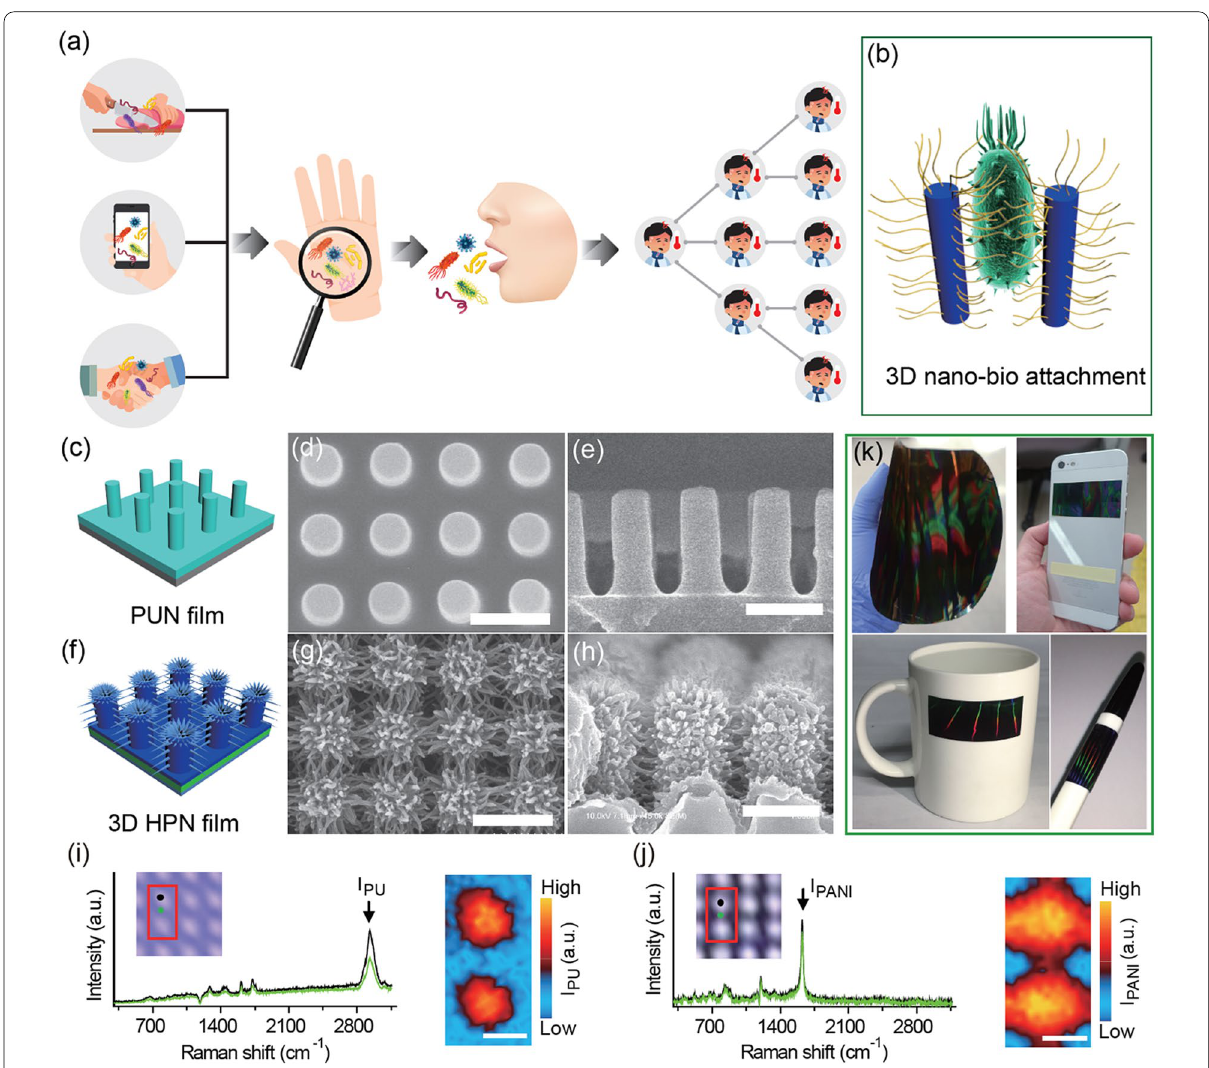
Fig. 1 Schematics of a a widespread of bacteria pathogens by human hand contacts; b a desired attachment of bacteria to a solid surface of capture platform by a pathogen to 3D nanostructural attachments; c PUN and f 3D HPN films. SEM images of d , e PUN and g , h 3D HPN films. Raman spectra and maps of i PUN and j 3D HPN films. Polyurethane and polyaniline were denoted as PU and PANI, respectively. k Photographs of a large‑area 3D HPN film and its practical applications as attachments to a smartphone, ceramic cup, and pen. Scale bar: 1